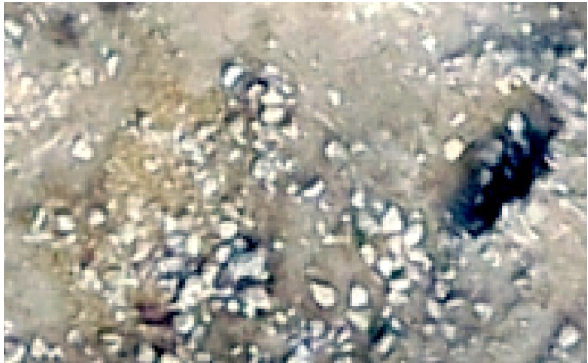
Figure 7. Detail of RPAS orthophoto